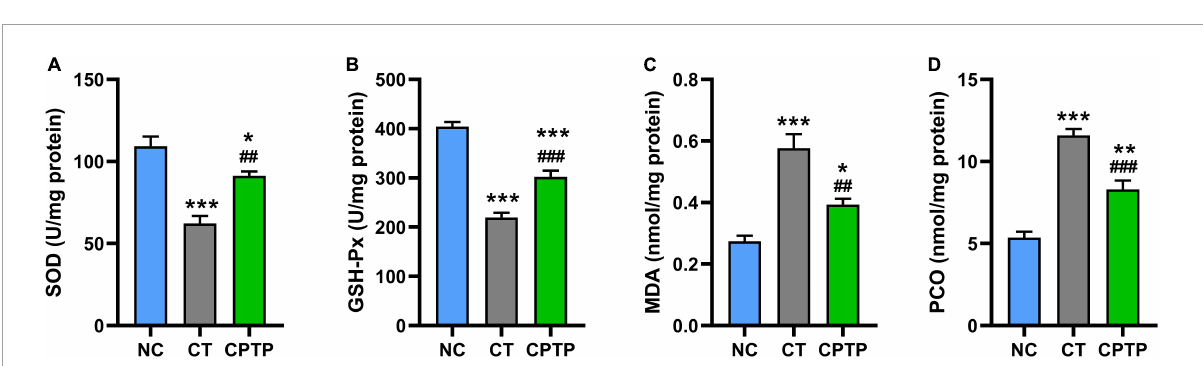
FIGURE4 Chinese pond turtle peptide (CPTP) enhanced the antioxidant capacity in female flies. (A) Superoxide dismutase (SOD) activity; (B) GSH-Px activity; (C) Malondialdehyde (MDA) content; and (D) Protein carbonyl (PCO) content. n = 180–210 flies per group. The data are presented as mean ± SEM. Statistical test: two-tailed unpaired t -test (* P < 0.05, ** P < 0.01, and *** P < 0.001 vs. NC group; ## P < 0.01 and ### P < 0.001 vs. CT